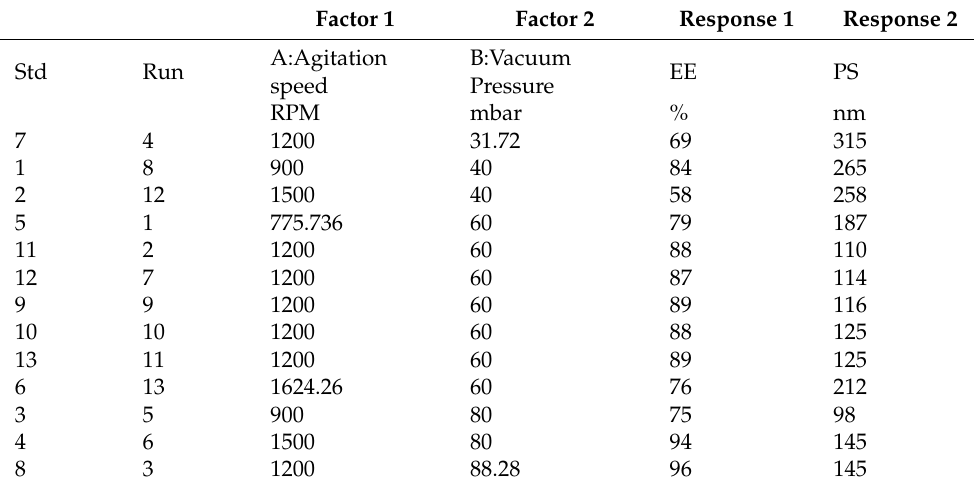
Table 2. Experimental runs projected and their responses observed.